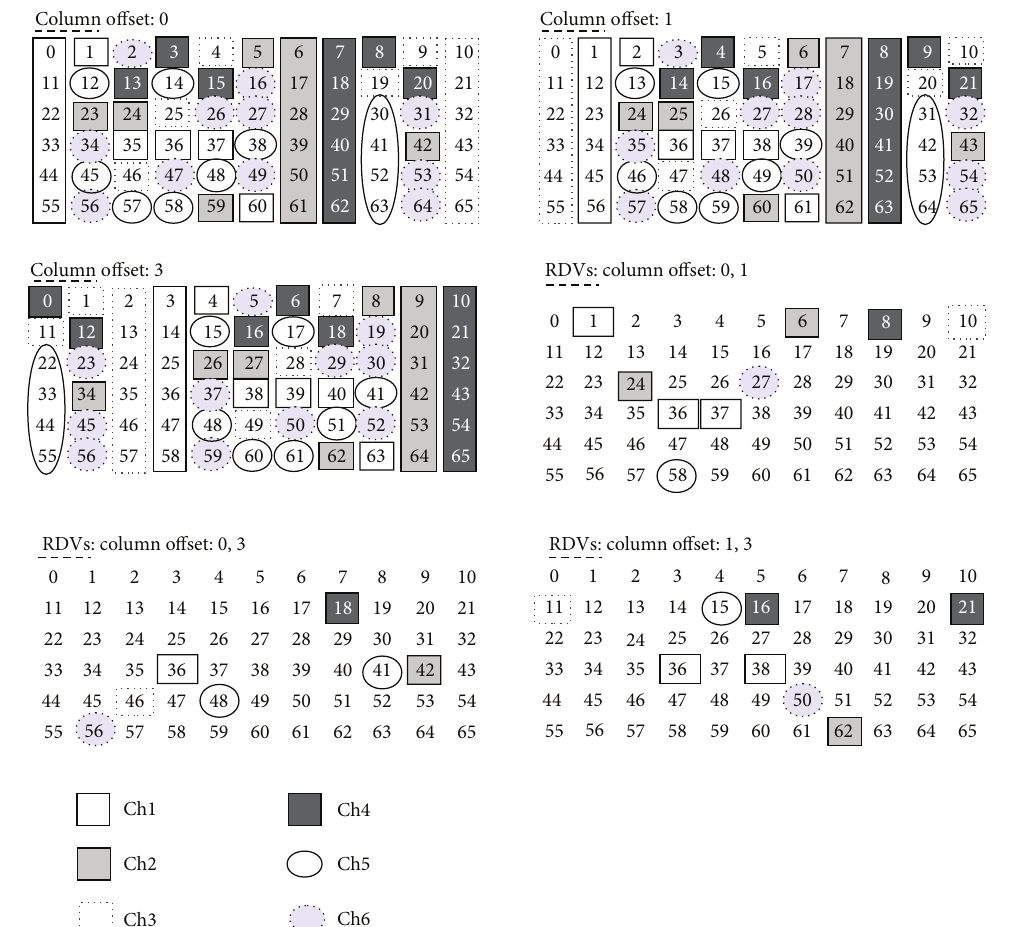
Figure 6: MtQS-DSrdv: different column offsets, CRs meet at least in 𝑟 slots.